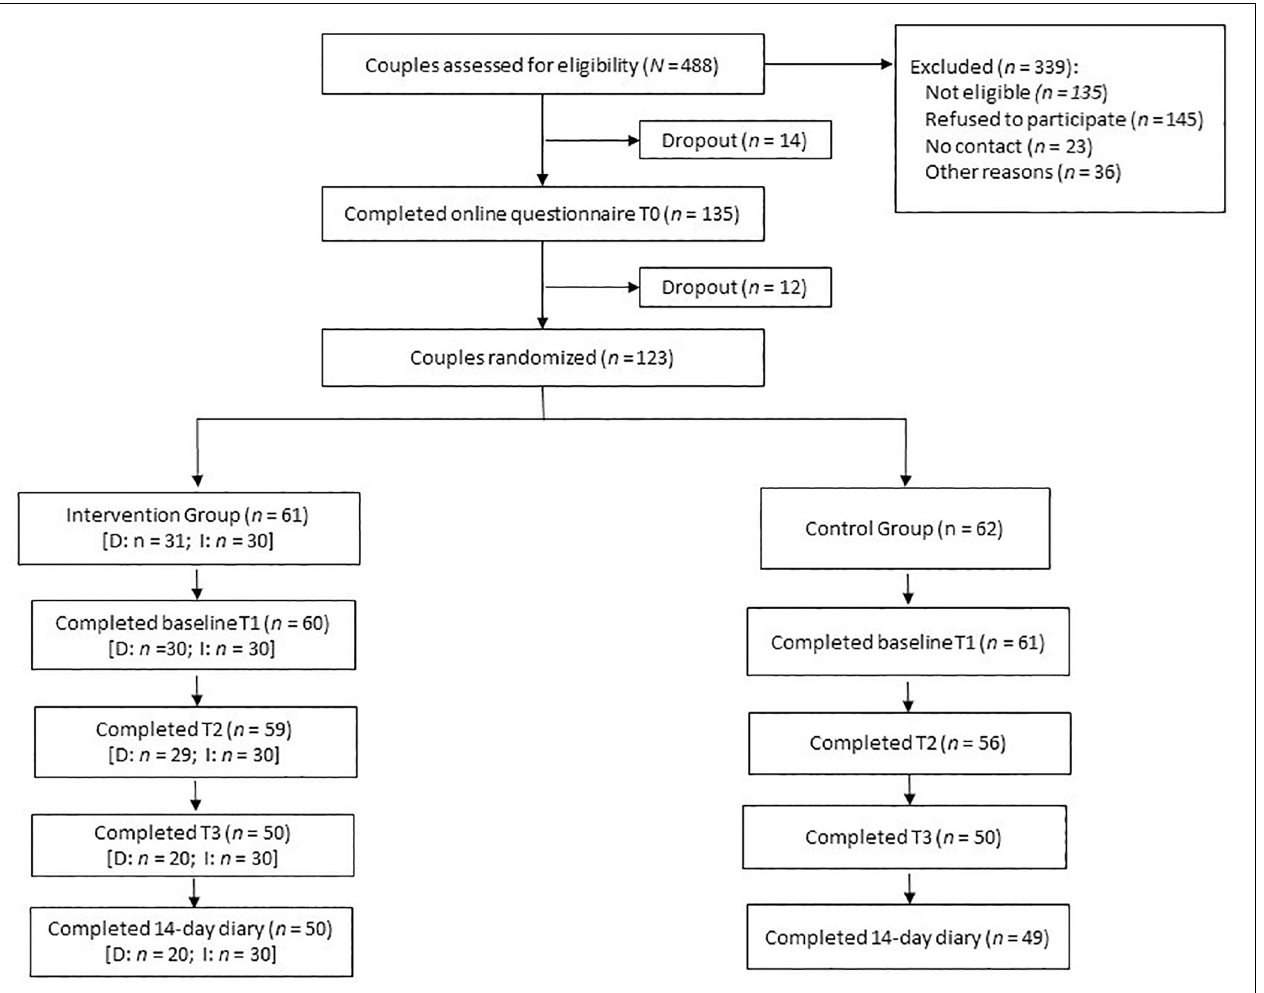
FIGURE 1 | Flow chart of participating couples. D, dyadic version of intervention; I, individual version of intervention.